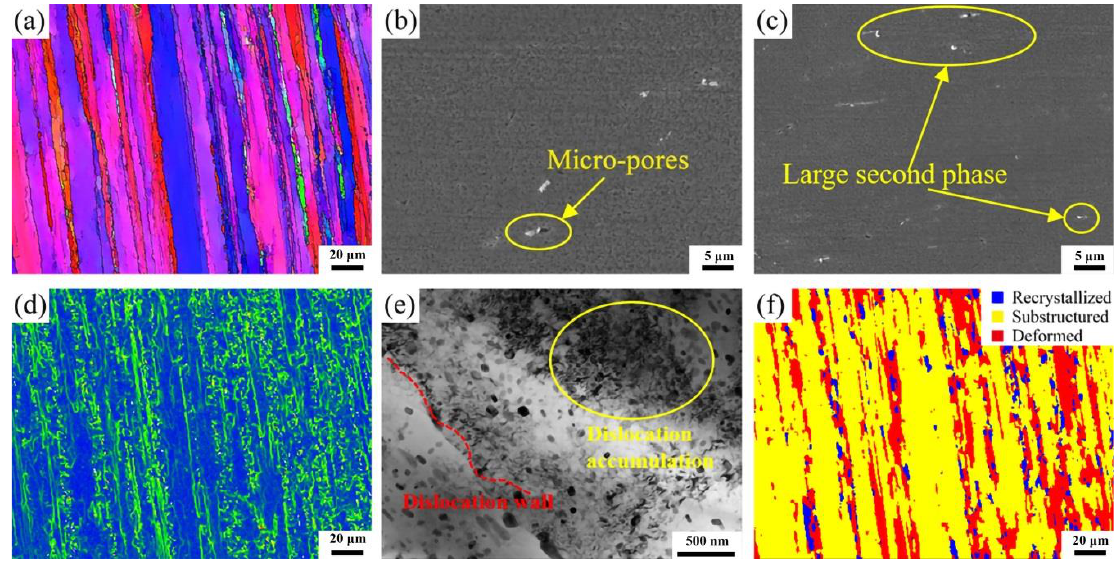
Figure 9. Microstructure in the instability area of Al-Zn-Mg-Cu alloy: ( a ) IPF, ( b , c ) SEM, ( d ) KAM, ( e ) TEM, ( f ) Distribution of recrystallized grains, sub-crystal structure and deformed structure in the EBSD maps.